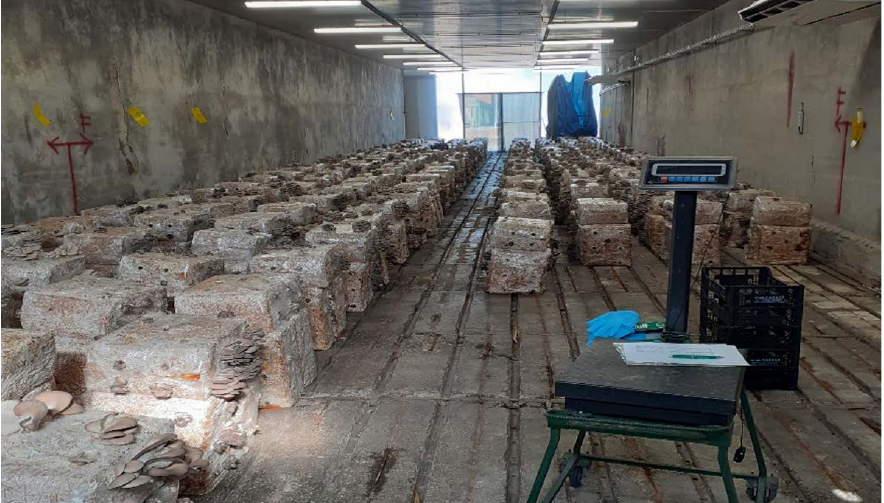
Figure 1. Mushroom growing room at the Funghitex company (Photo courtesy of Funghitex).